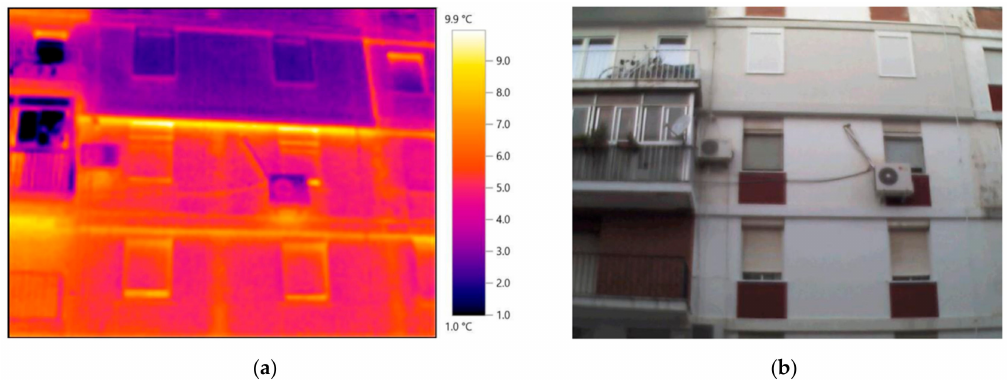
Figure 20. ( a ) Dwelling thermography test after refurbishment; ( b ) Visual